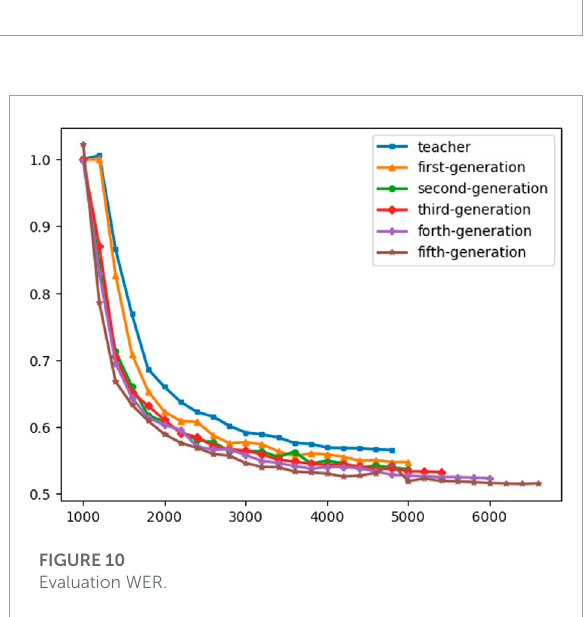
FIGURE 8 Experiment design.